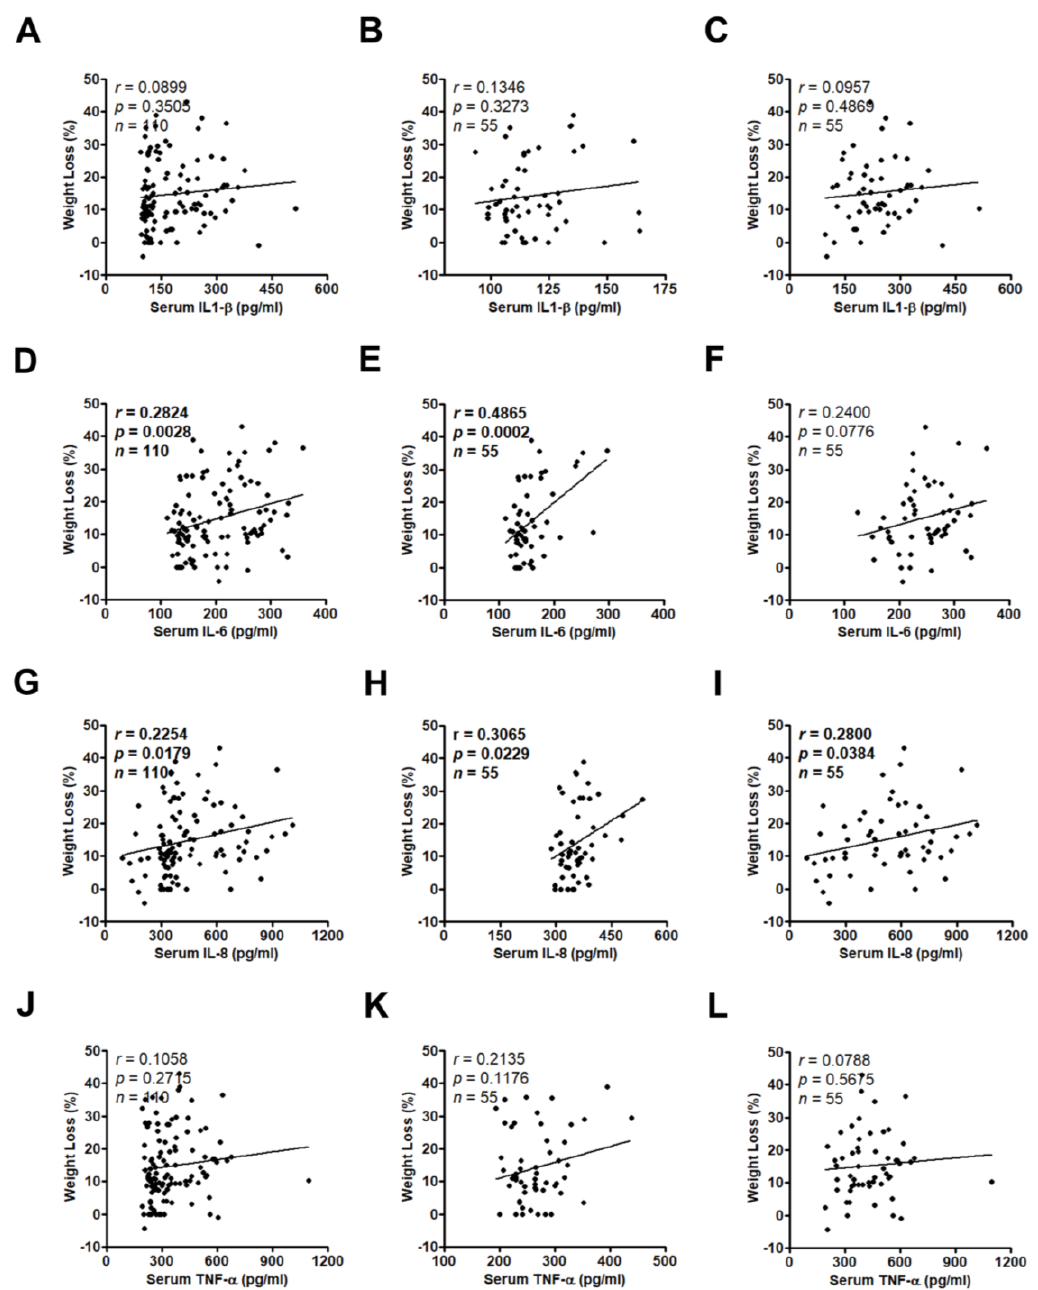
Figure 5. The correlation between IL-1β, IL-6, IL-8, or TNF-α serum concentrations from all patients ( A , D , G , and J ), the resected group ( B , E , H , and K ), or the locally advanced group ( C , F , I , and L ) and weight loss was analyzed by Pearson’s correlation analysis. The bold value indicates p < 0.05.